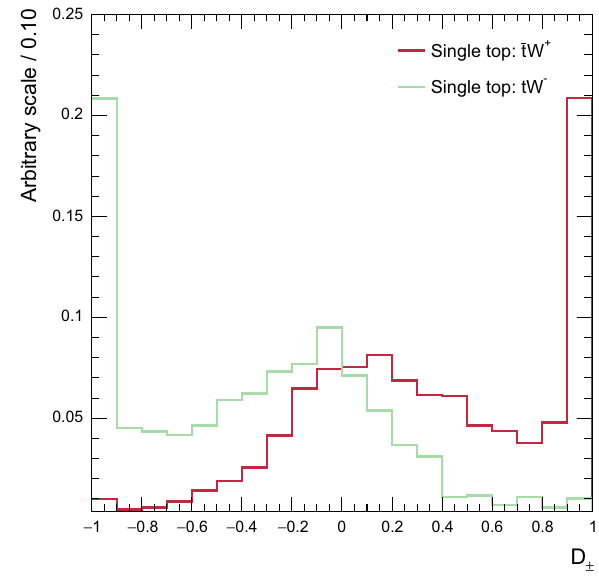
Fig. 2 Normalised distribution of the D ± asymmetry observable, as defined in (6), for the charge-conjugate processes tW + and ¯ t W − . Back- grounds such as t ¯ t production are expected to be distributed symmetri- cally around